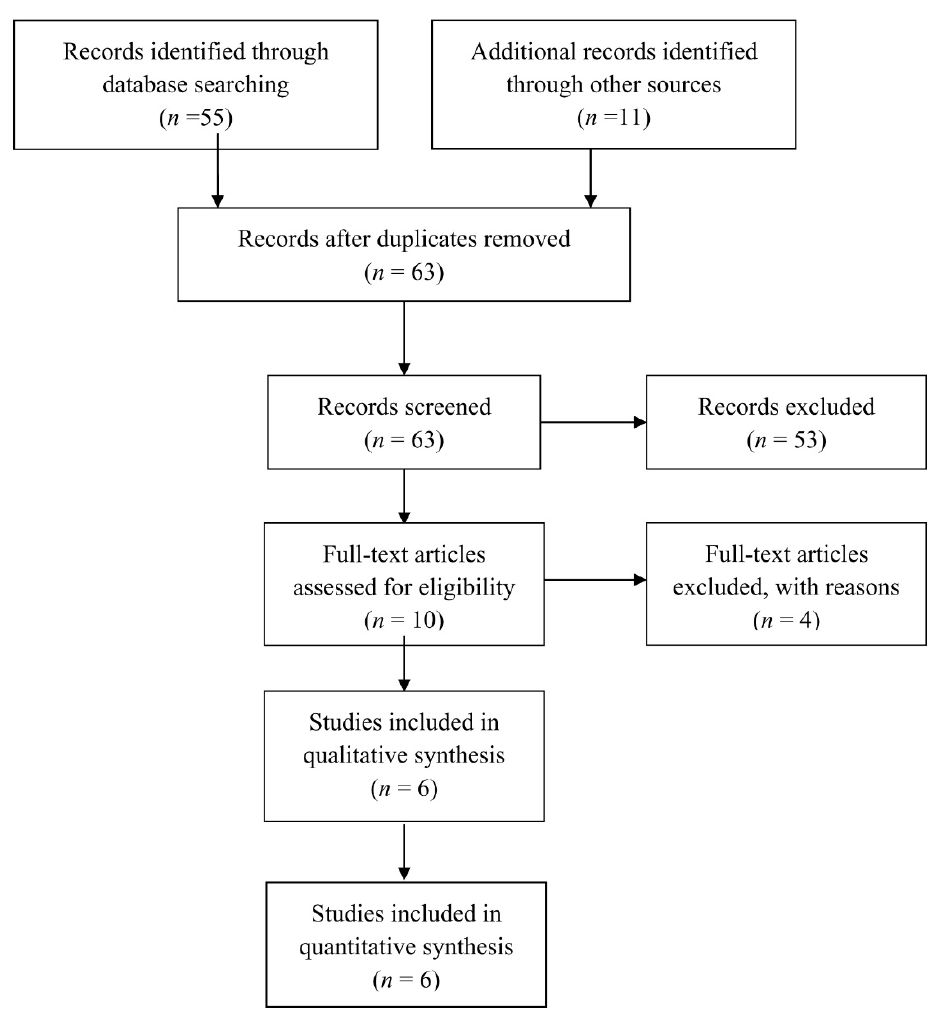
Figure 1. Flowchart depicting the selection process for inclusion of manuscripts in the